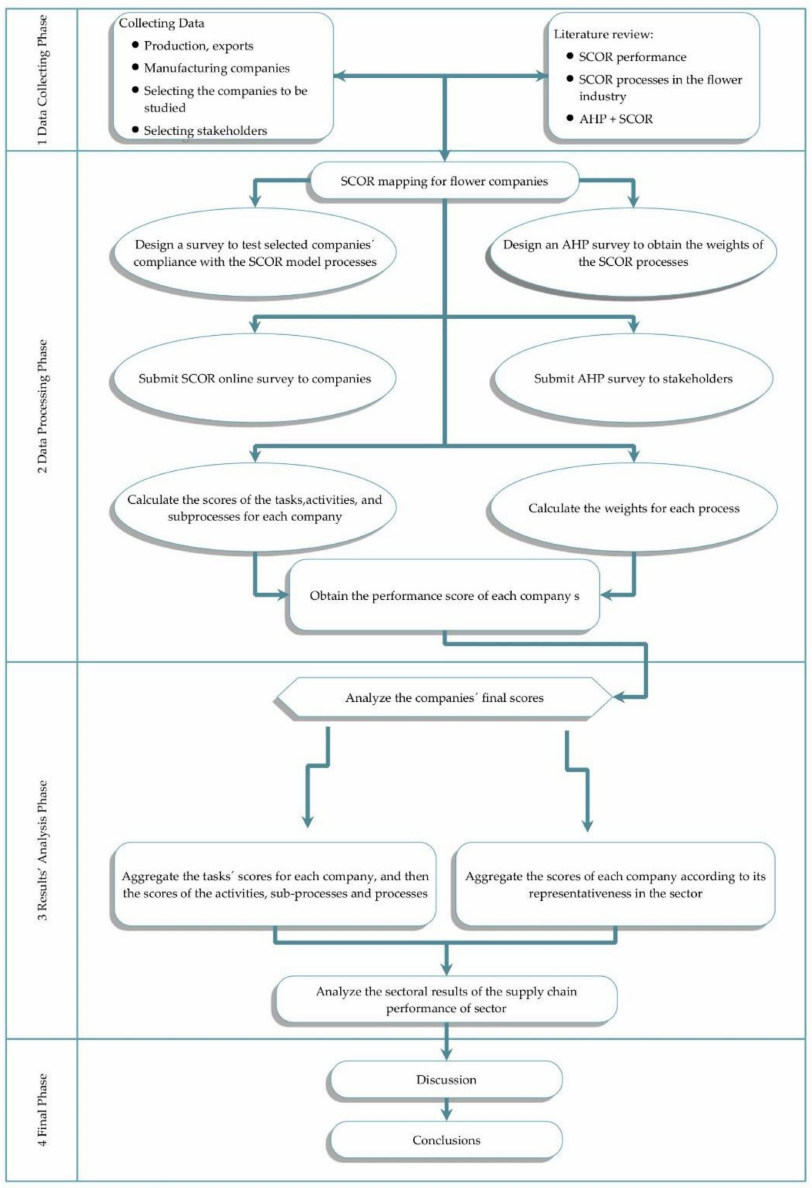
Figure 1. Methodology. Source: Authors’